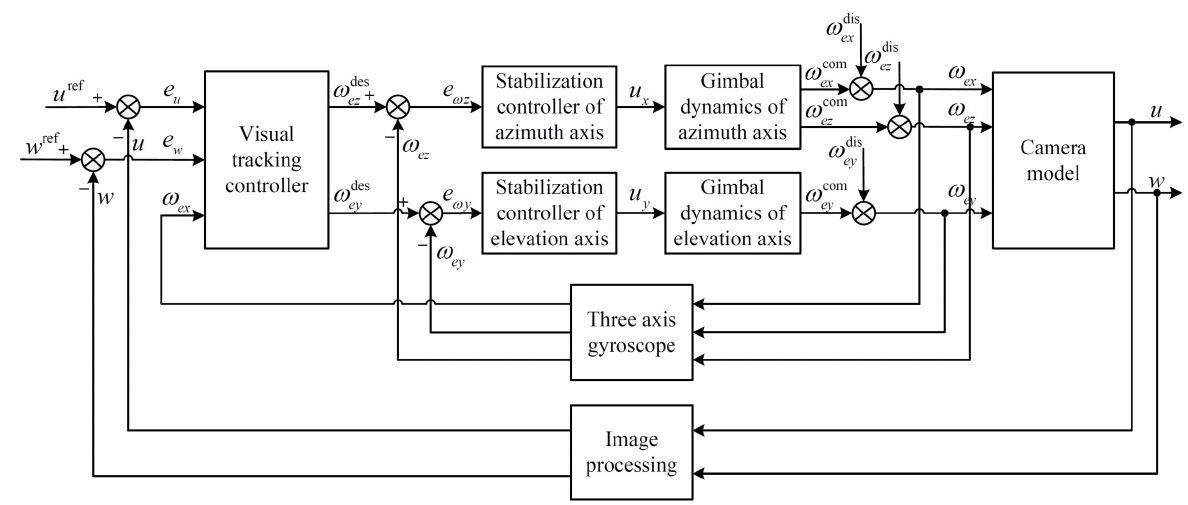
Figure 7. Cascaded control system